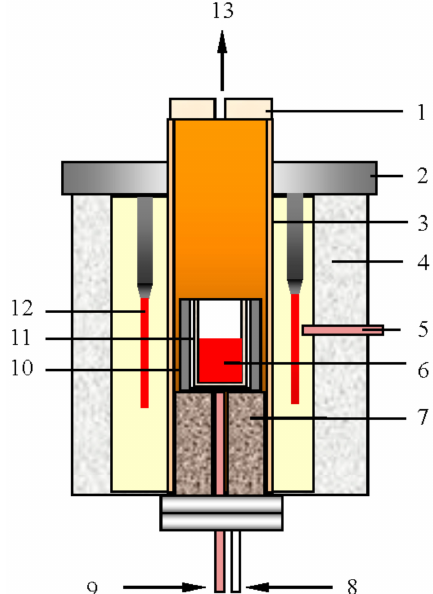
Figure 1. Illustration of the experimental furnace used in this study. 1—cap; 2—furnace cover; 3—corundum tube; 4—insulation layer; 5—thermocouple A; 6—stainless steel slag; 7—refractory; 8—gas inlet; 9—thermocouple B; 10—graphite crucible; 11—molybdenum crucible; 12—MoSi 2 heating elements; 13—gas